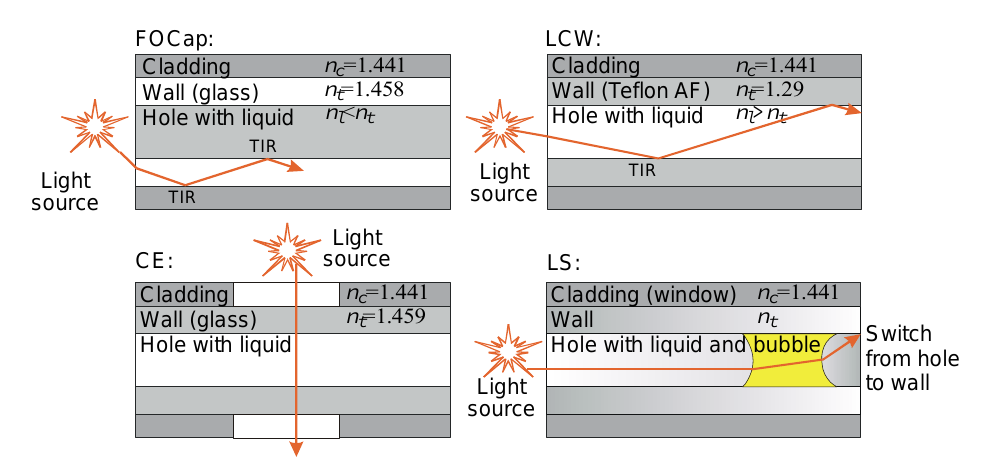
Figure 1. Examples of optical signal path in capillary